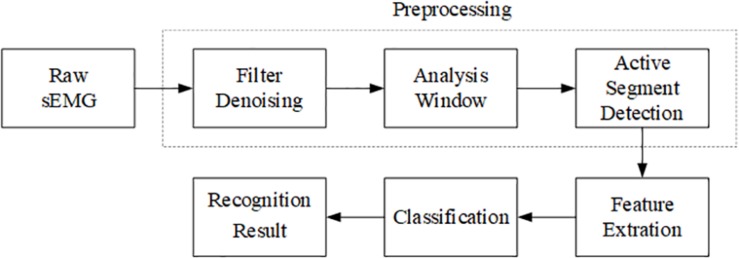
Flowchart of the procedures for sEMG processing.